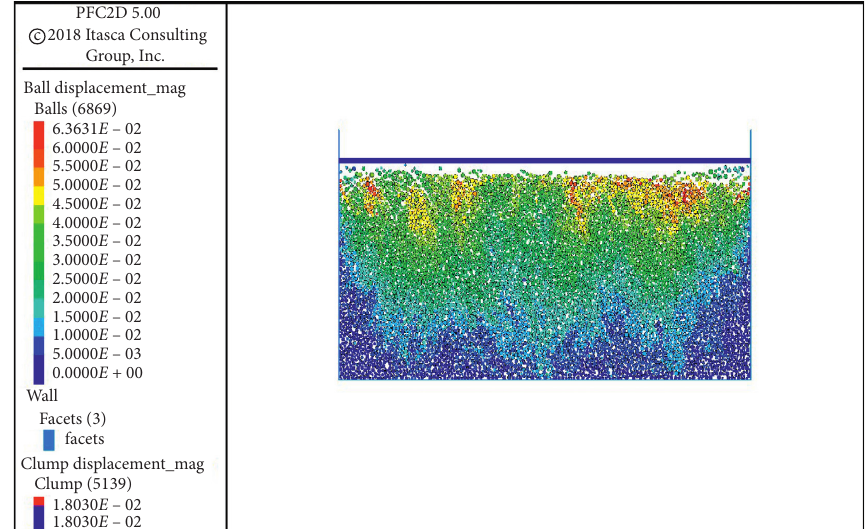
Figure 23: Discrete element particle migration map of 70 cm thick reclaimed soil with five compactions.